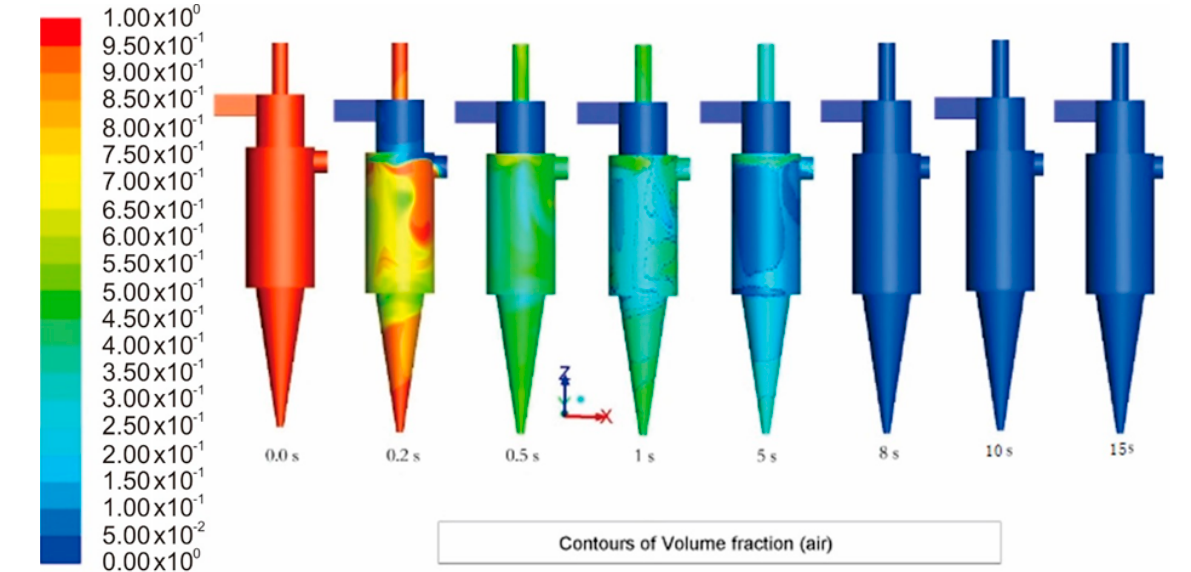
Figure 5. Contours of air volume fraction at different time inside TPHS with the inlet velocity of 5 m/s.